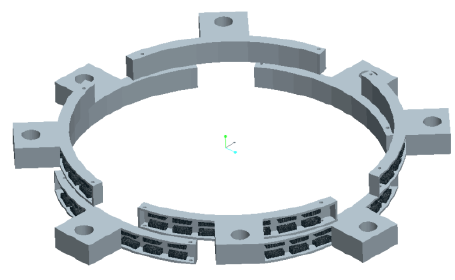
Figure 12. The MFL probing system integrated eight probes in two layers.